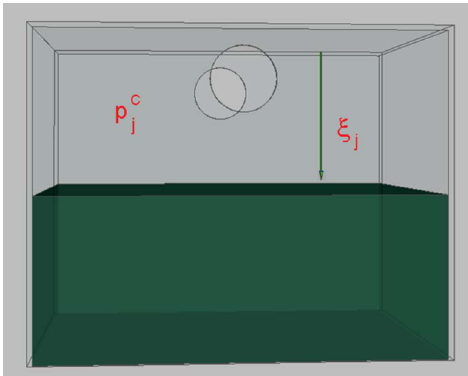
Figure 20. Reference sketch for model